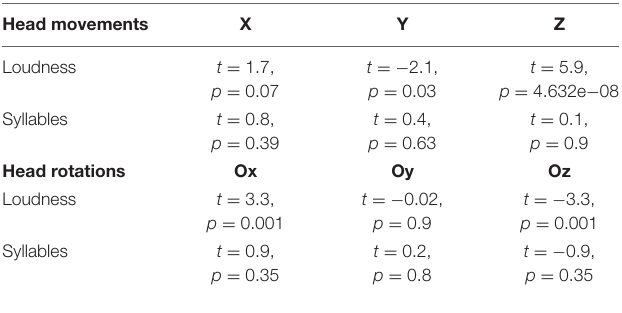
TABLE 1 | Statistical analysis